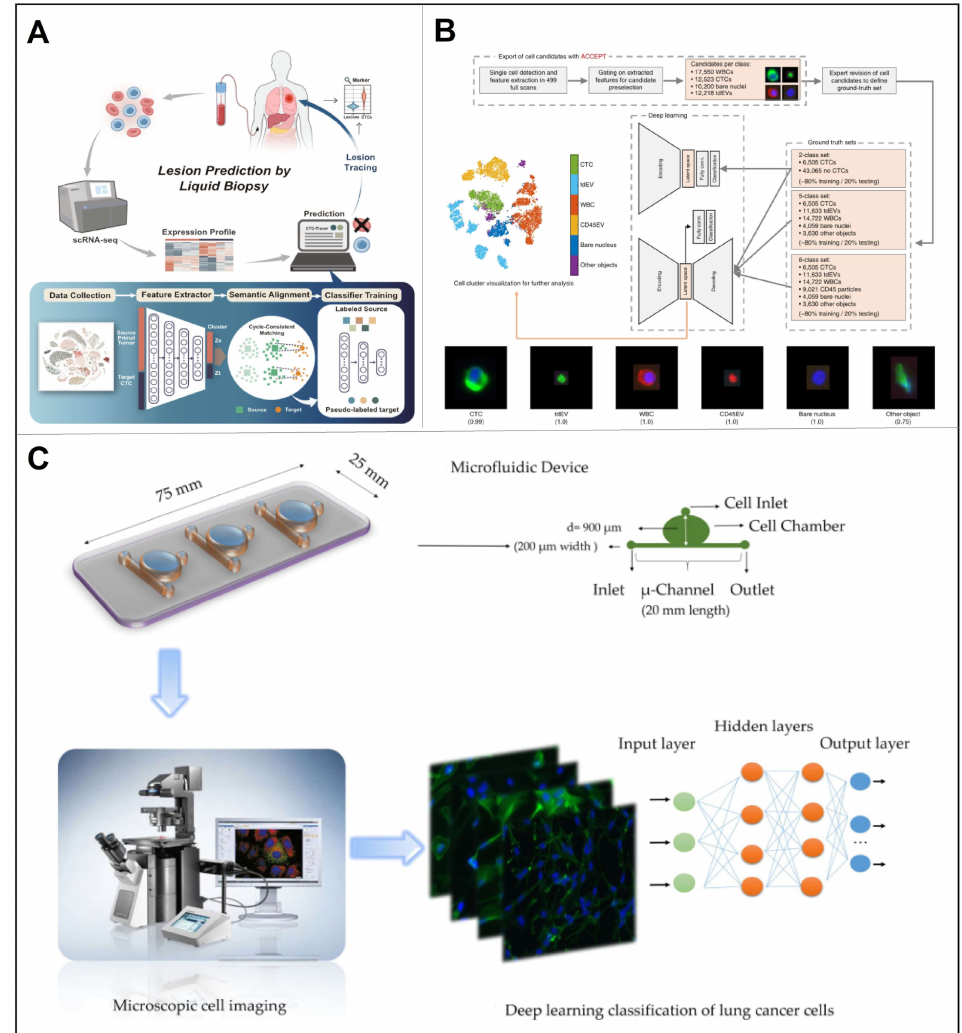
Figure 12. ( A ) Overview of the main function of CTC-Tracer and its application. Reproduced with permission from [102]. ( B ) Overview of the analysis workflow used [104]. ( C ) Overview of the combined microfluidic deep learning approach. Reproduced with permission from